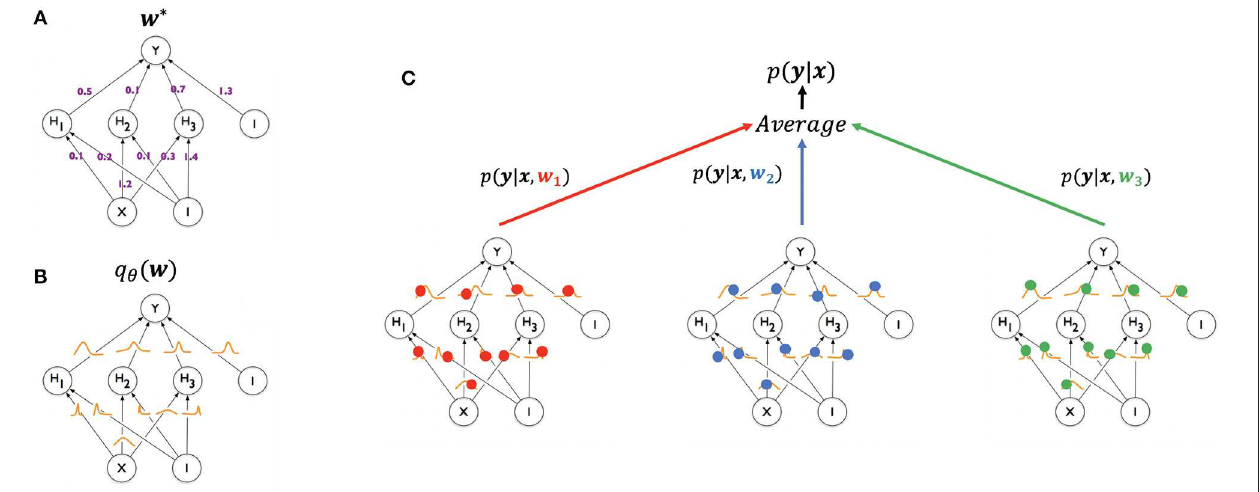
FIGURE 1 | Illustration of generating a prediction from a Bayesian neural network using Monte Carlo sampling (modified from Blundell et al., 2015). A standard neural network ( A , top left) has one weight for each of its connections ( w ∗ ), learned from the training set and used in generating a prediction for a test example. A Bayesian neural network ( B , bottom left) has, instead, a posterior distribution for each weight, parameterized by theta ( q θ ( w )). The process of training starts with an assigned prior distribution for each weight, and returns an approximate posterior distribution. At test time ( C , right), a weight sample w 1 (red) is drawn from the posterior distribution of the weights, and the resulting network is used to generate a prediction p ( y | x , w 1 ) for an example x . The same can be done for samples w 2 (blue) and w 3 (green), yielding predictions p ( y | x , w 2 ) and p ( y | x , w 3 ), respectively. The three networks are treated as an ensemble and their predictions